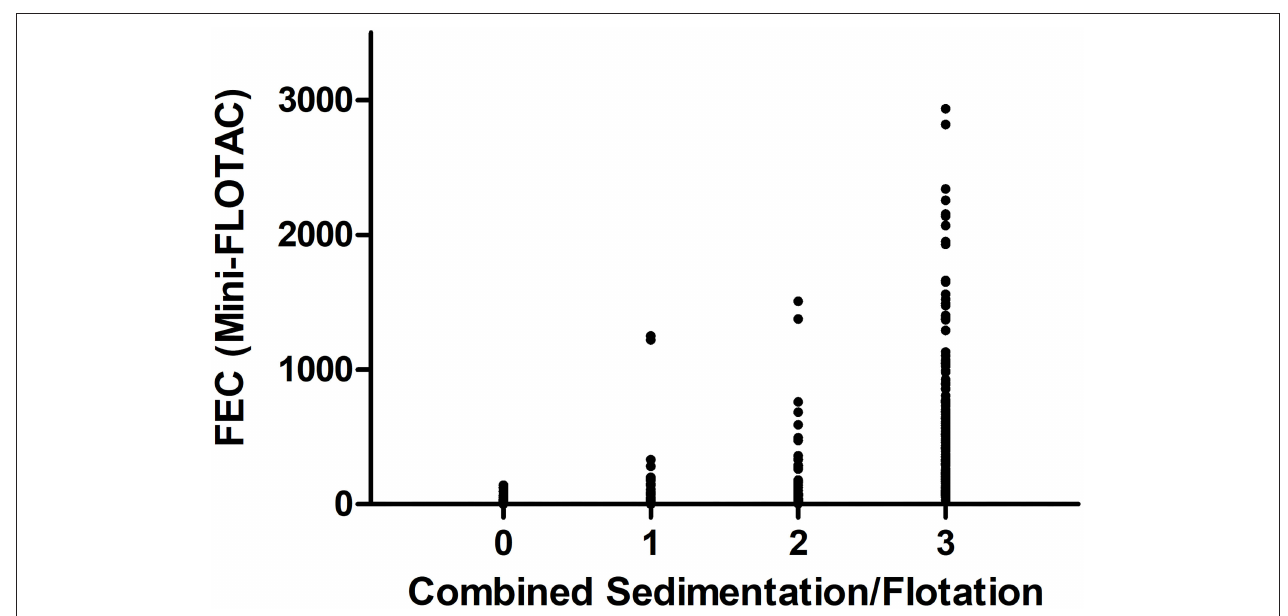
FIGURE 1 | Comparison of faecal analyses methods, referring to counting results of strongyle type eggs of 484 faecal samples. Results of the combined sedimentation/flotation methods are plotted as classes (0: no eggs found; 1: 1–10 eggs per slide; 2: 11–40 eggs per slide; 3: ≥ 41 eggs per slide) vs. eggs per gram faeces (epg) as determined using